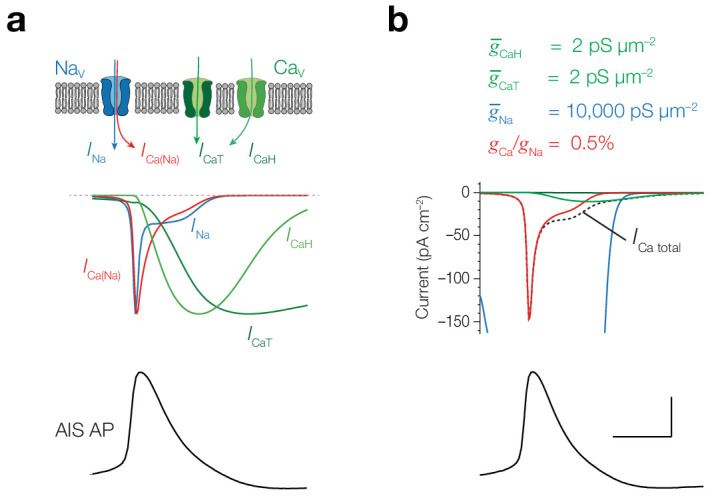
ICa compared to ICa(Na) in a single compartment model.(a) From top to bottom, schematic of a NaV channel mediating Na+ and Ca2+ current (INa and ICa(Na)) and a CaV channel mediating ICaT and ICaH, peak normalized simulated currents (INa, ICa(Na), ICaH and ICaT) in a single compartment activated by an AIS AP waveform. Currents are normalized to peak amplitude. Note that ICa(Na) is ~10 fold more rapid compared to ICaH and ICaT. The difference in shape of ICa(Na) and INa reflects the different driving forces. Since the equilibrium potential for Ca2+ (+140 mV) is higher than for Na+ (+55 mV), the driving force for ICa(Na) is less affected during the voltage trajectory of the AP. (b) Absolute current amplitudes comparing ICa(Na) to ICaH and ICaT as well as the total ICa for typical channel densities (as noted above) and 0.5% conductivity ratio. INa is clipped to visually compare the Ca2+ currents. Note that ICa(Na) dominates the Ca2+ charge for rapid action potentials. Scale bars, 50 mV and 0.5 ms.